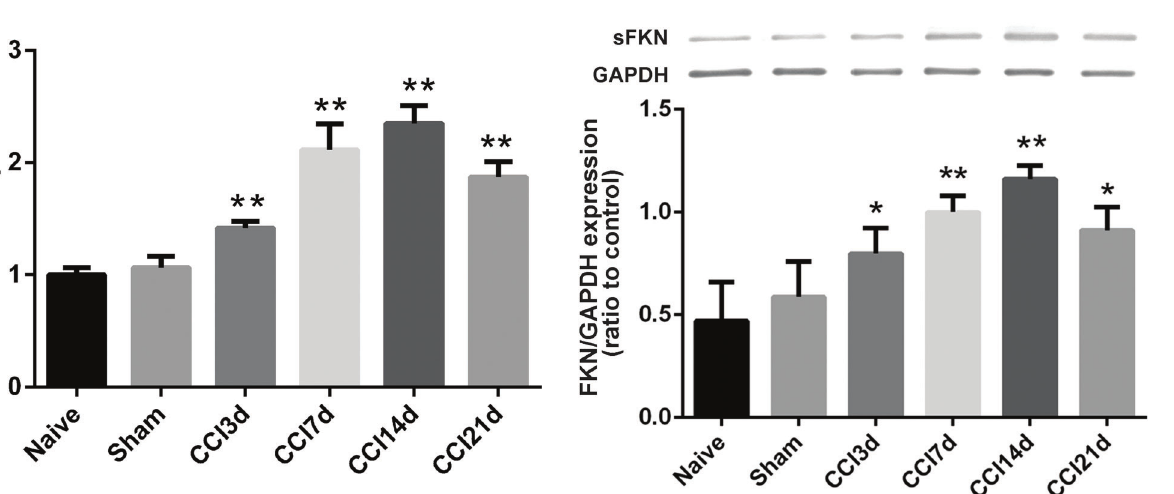
Figure 4. Western blot of soluble fractalkine (sFKN) expression. Protein samples were isolated from the CSF-contacting nucleus in naive, sham, and chronic constriction injury (CCI) rats on days 3, 7, 14, and 21. *P o 0.05 vs sham group, **P o 0.01 vs sham group, n=5, F=19.065 (one-way ANOVA, LSD test). CSF: cerebrospinal fl